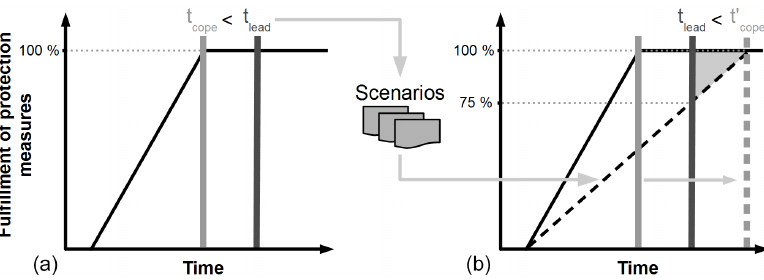
Figure 4. Measuring the performance of disaster management. Coping time t cope refers to the time needed to put all protection measures into place (light grey lines). Whether coping time is above or below the lead time threshold t lead (dark grey lines) determines whether community protection can be ensured or not. The black lines present the degree of fulfilment of protection measures. Table 1. Characterization of geographic and demographic settings and comparison across the two study sites. Setting Characteristics Urban area Leipzig